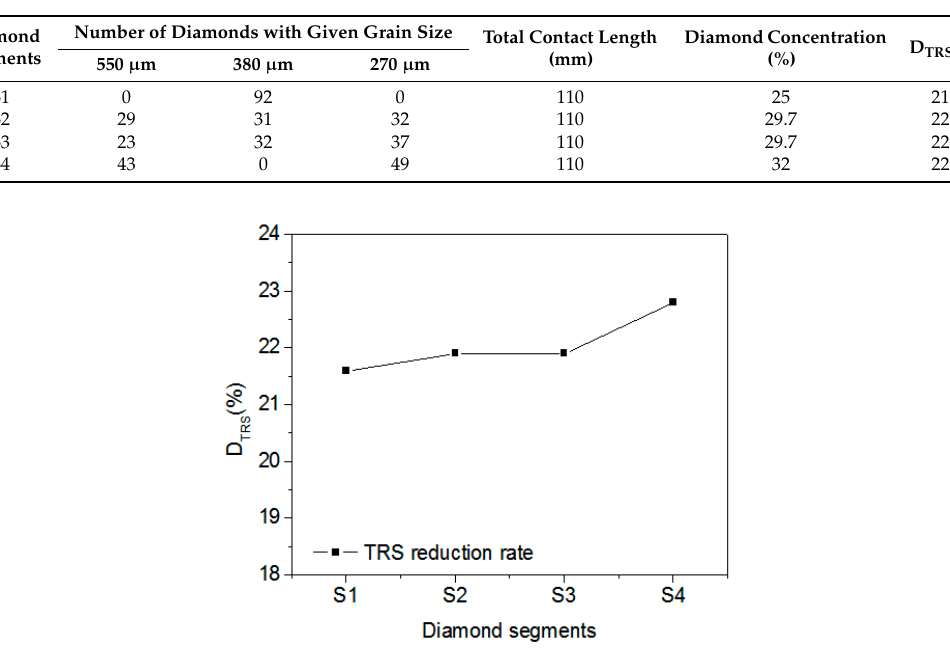
Figure 9. Percent TRS reduction for the various diamond segments (see Table 6).